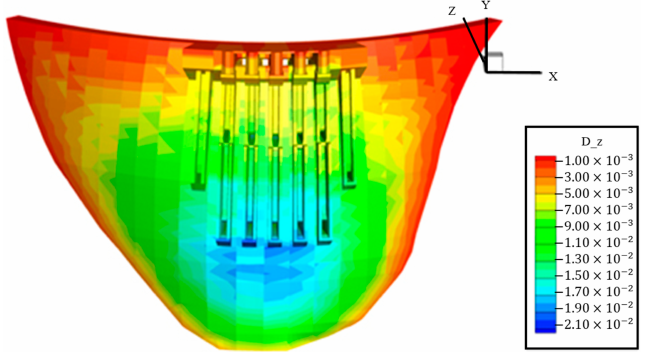
Figure 7. Annual variation of cross section’s radical displacement in 2014.